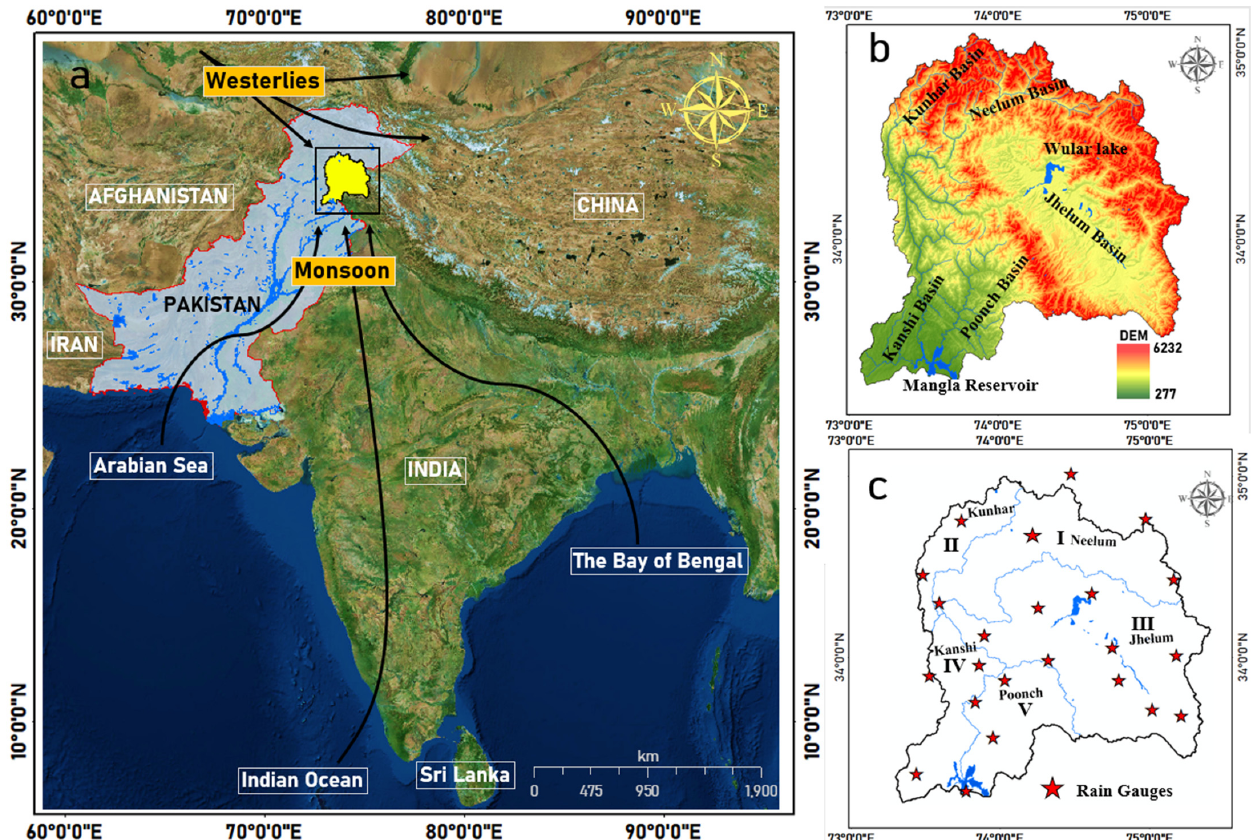
Figure 1. The geographical location of the study area. ( a ) seasonal influences of precipitation sources ( b ) Elevation ( c ) distribution of rain gauges in SBs. Whereas I, II, III, IV and V represent Neelum, Kunhar, Jhelum, Kanshi and Poonch sub-basins, respectively. Table 1. Topological information of five sub-basins of